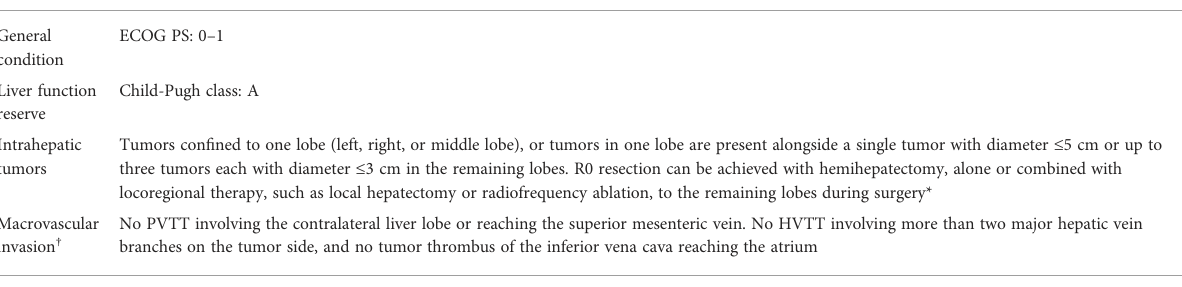
TABLE 3 Proposed criteria for patients with potentially resectable HCC before lenvatinib plus anti-PD-1 therapy.